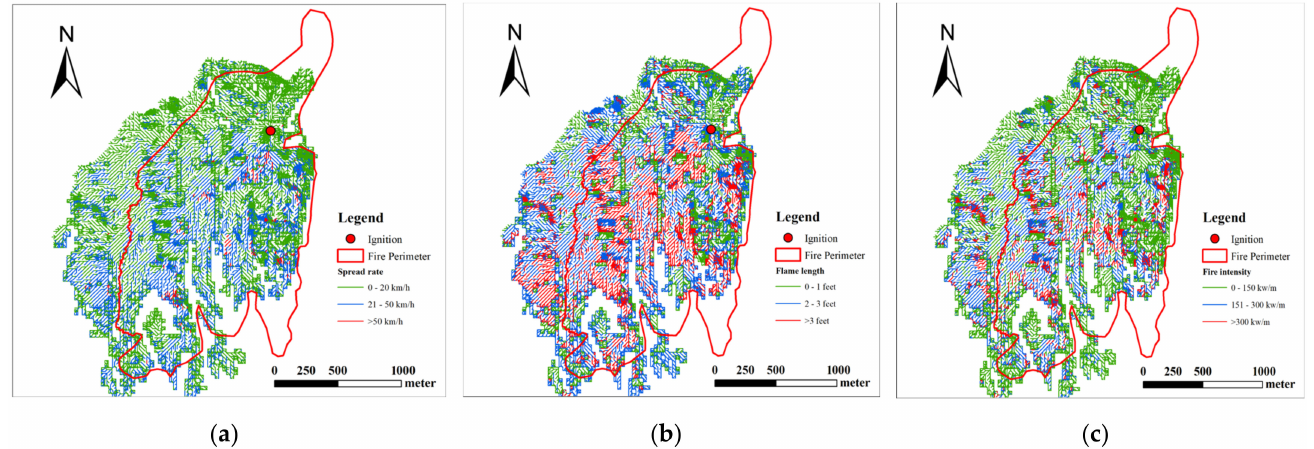
Figure 9. Wildfire spread characteristics in IGN-based landscape. ( a ) Spread rate; ( b ) flame length; ( c ) fire